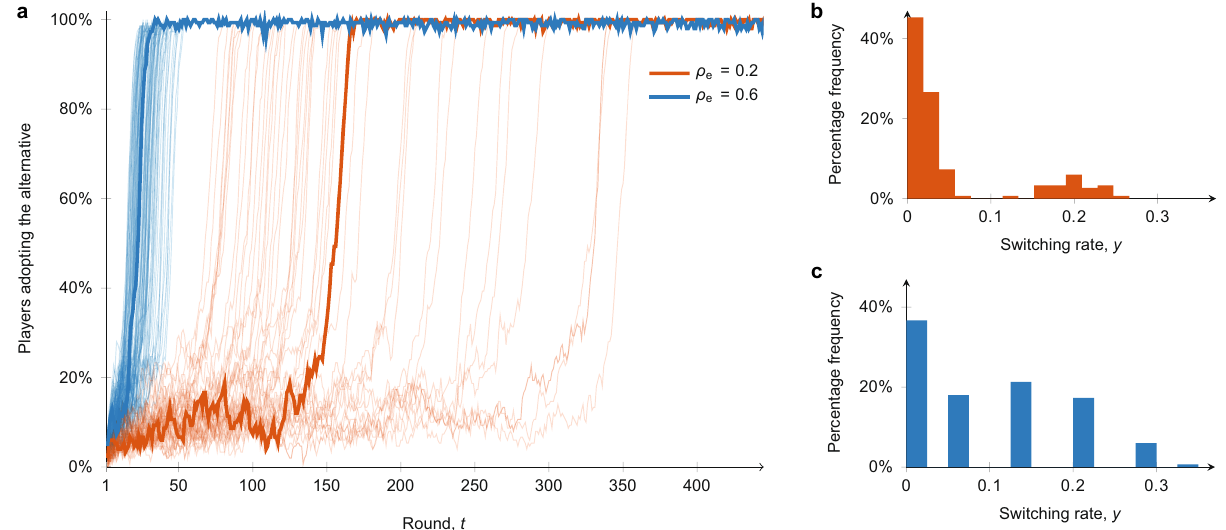
Fig. 2 Sample simulations of the ABM with two different fractions ( ρ e ) of explorers relative to non-explorers. Simulations are performed with n = 200 agents and 25% of committed minority. a Temporal evolution of the fraction of regular agents adopting the alternative with ρ e = 0.2 (orange) and ρ e = 0.6 (blue) in 50 simulation runs for each one of the two values of ρ e ; two representative simulations are highlighted. b Switching rates of the regular agents for ρ = 0.2 in a representative simulation. c Switching rates of the regular agents for ρ e